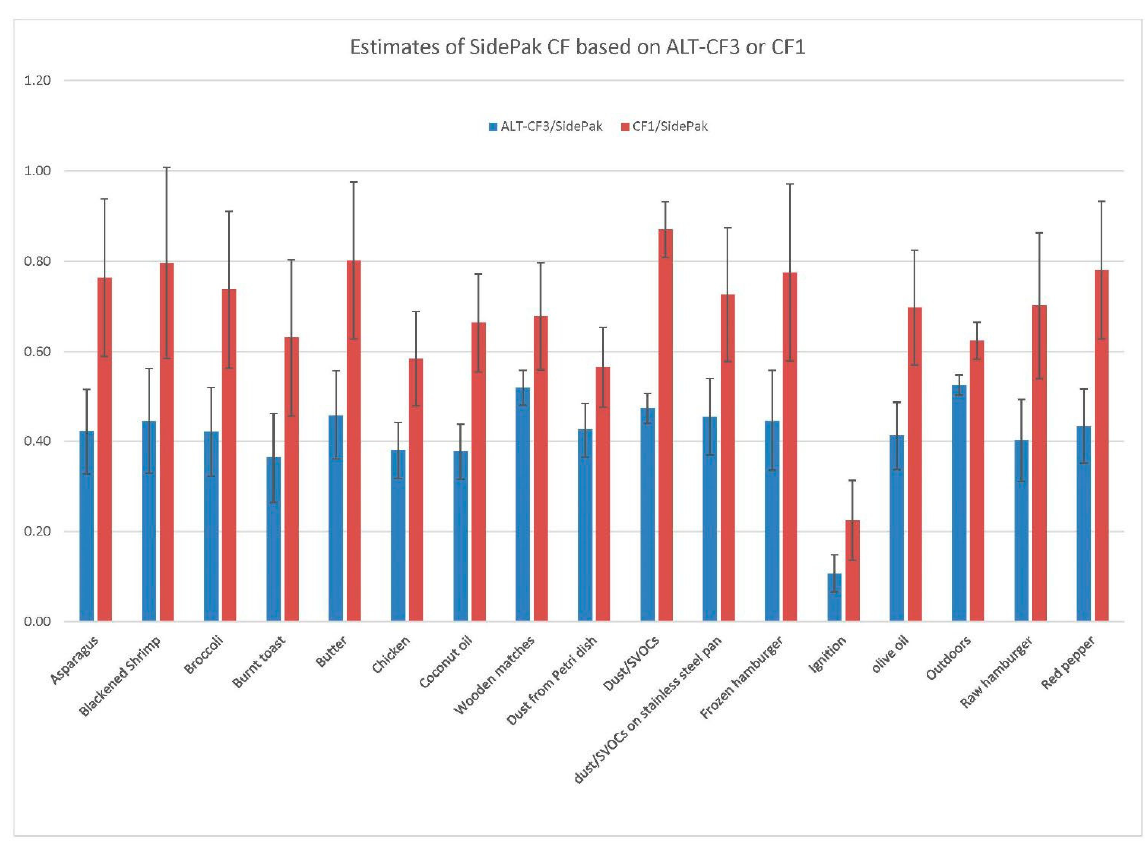
Figure 5. Ratios of the ALT-CF3 and Plantower CF1 PM 2.5 estimates with the co-located SidePak estimates for 17 sources. Error bars are propagated standard